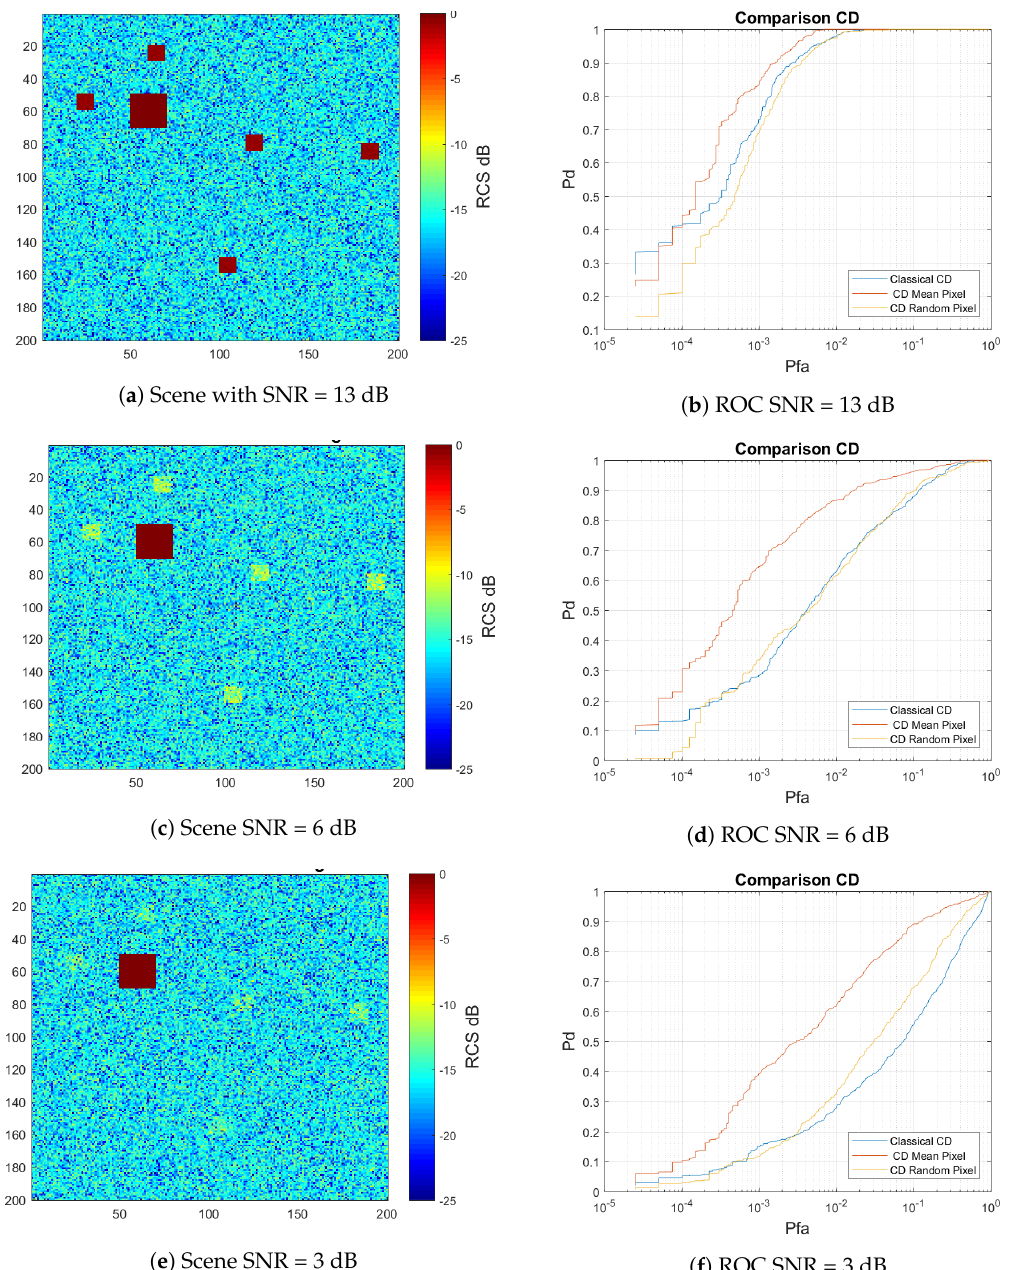
Figure 8. ROC curves for different target